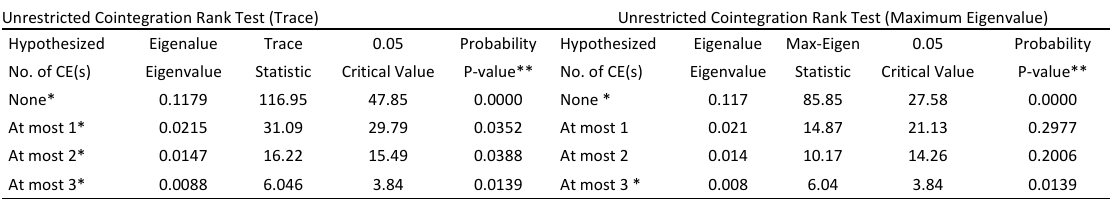
Table 3: Unrestricted co integration rank test (trace) and maximum Eigen statistics